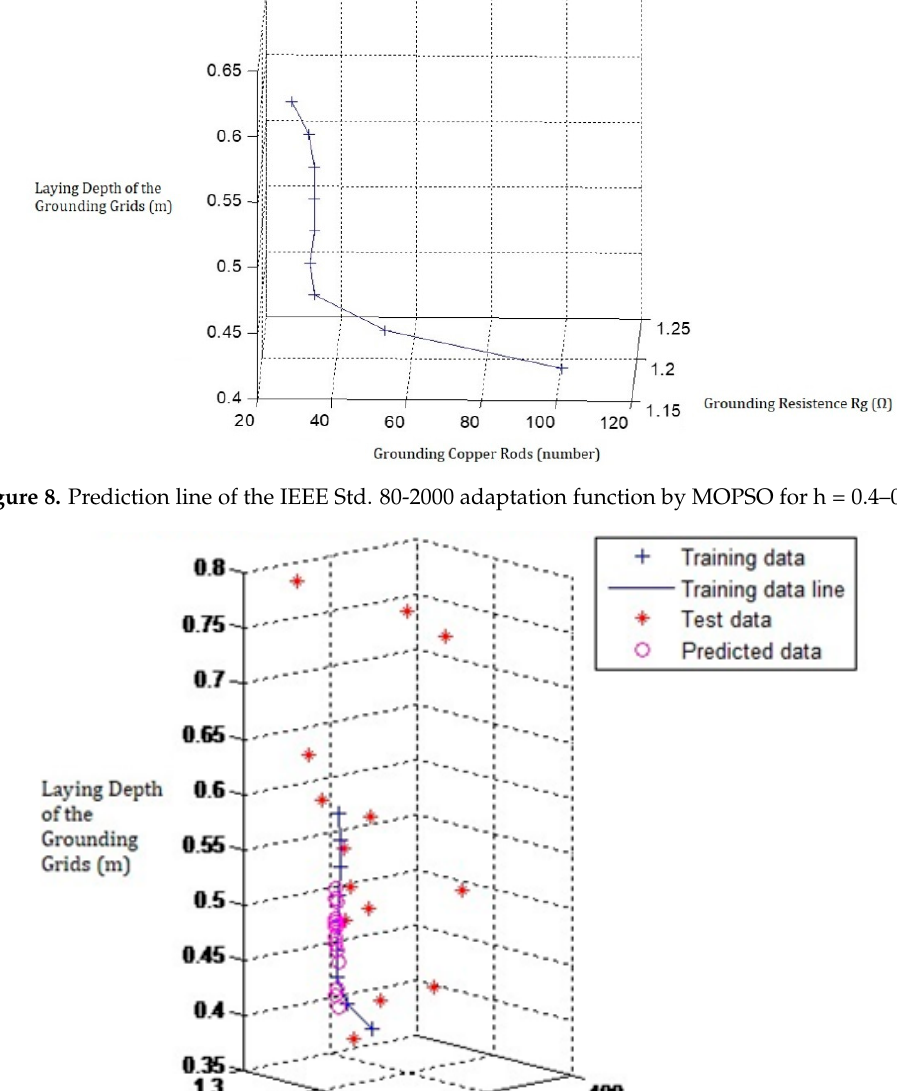
Figure 9. Prediction line calculation results by an RBF neural network.